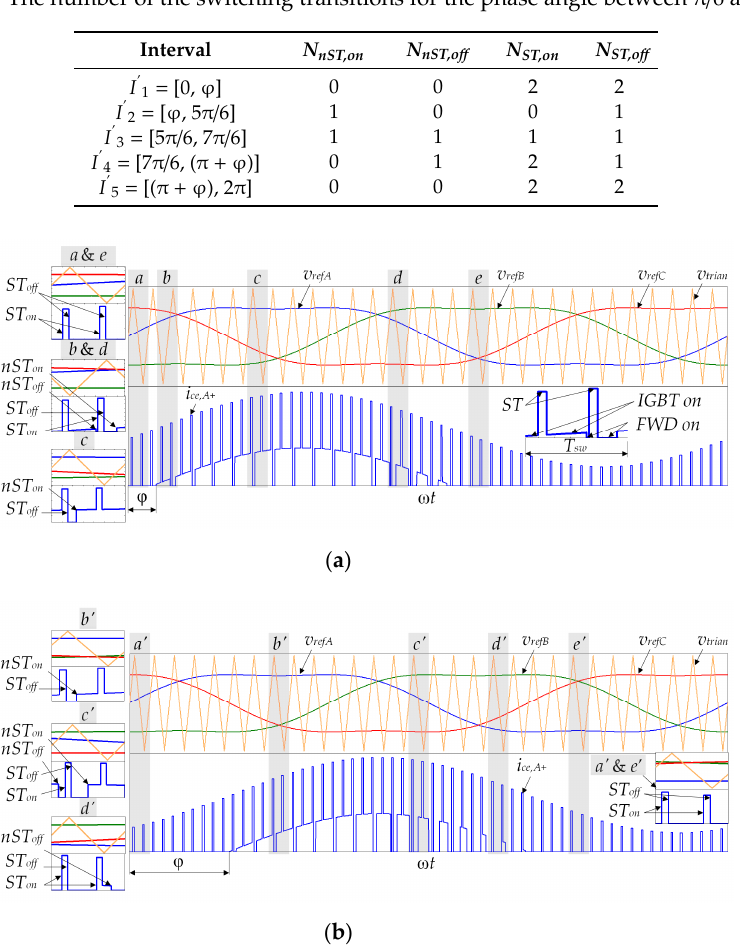
Figure 3. Waveforms of the reference voltages, the carrier triangular signal, and the IGBT current for the phase angle between 0 and π /6 ( a ) and the phase angle between π /6 and π /2 ( b ).